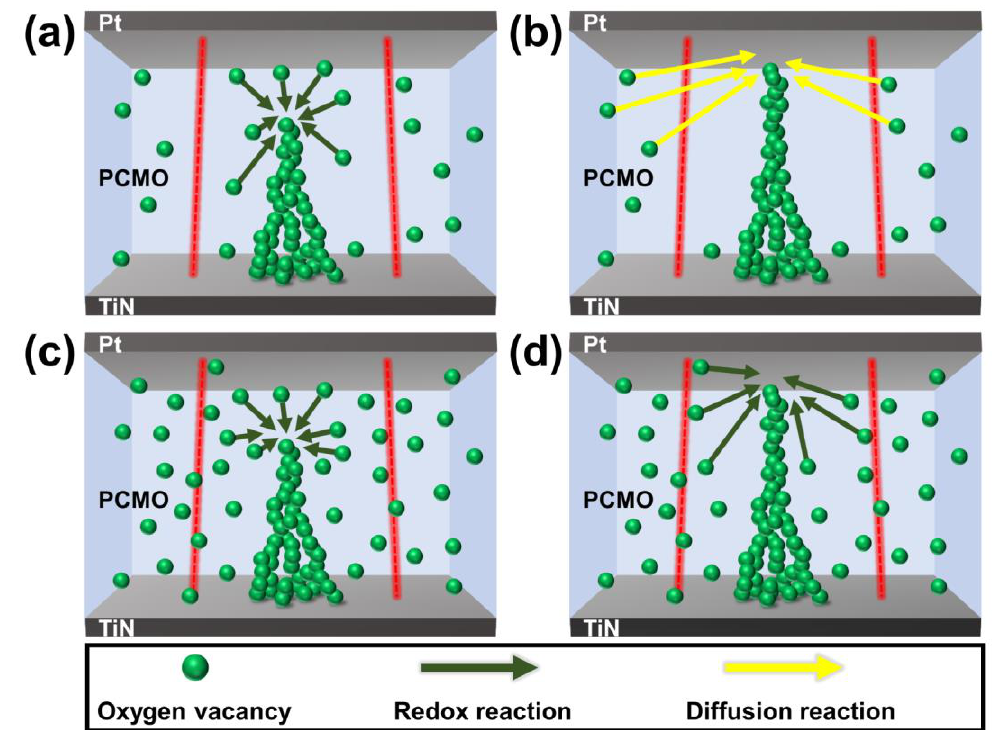
Figure 7. Schematic diagrams showing ( a ) the amount of OVs and ( b ) growth of the filament in the PCMO film grown at 300 mTorr; ( c ) the amount of OVs and ( d ) the growth of the filament in the PCMO film grown at 100 mTorr.